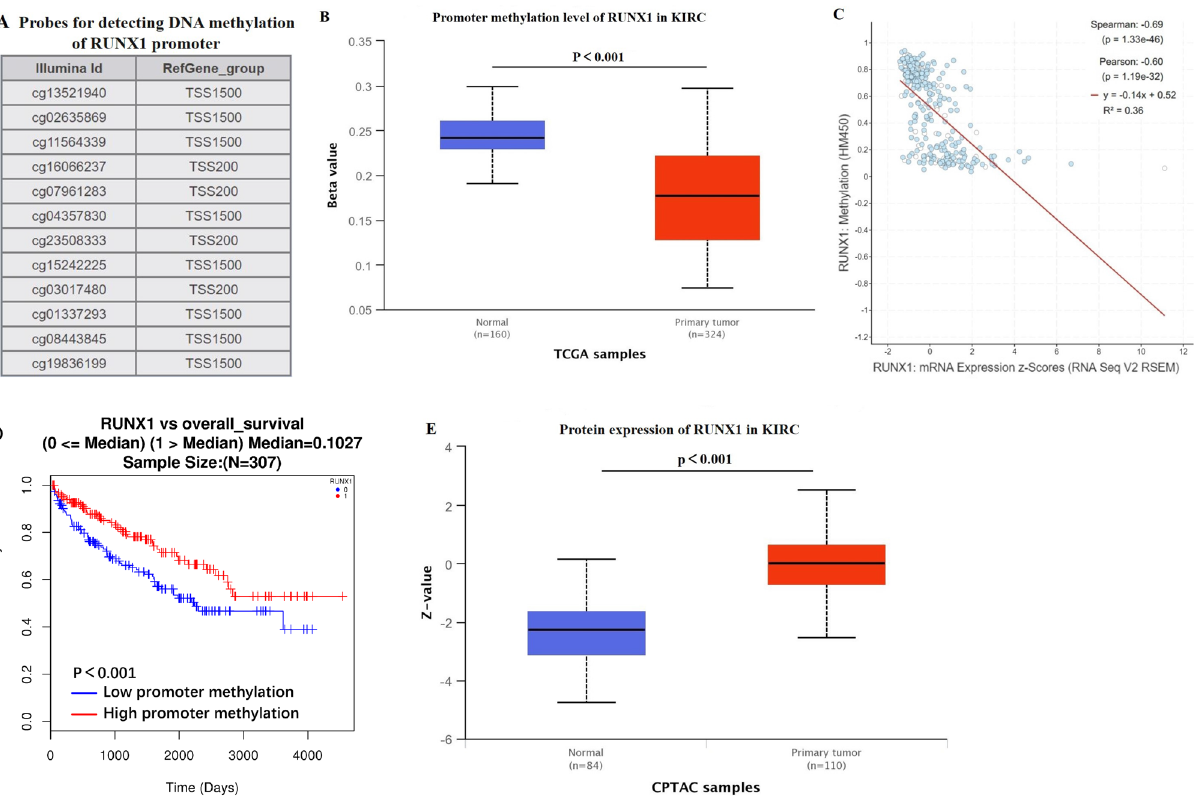
Figure 4. DNA methylation aberration of RUNX1 in KIRC. ( A ) Probes for detecting DNA methylation of RUNX1 promoter. ( B ) UALCAN analysis about the promoter methylation levels of RUNX1 in KIRC and normal samples. ( C ) The correlation analysis between the promoter methylation level of RUNX1 and its expression level based on cBioPortal database. ( D ) Correlation analysis between the promoter methylation level of RUNX1 and overall survival in KIRC patients by LinkedOmics. The blue line indicated low methylation level of RUNX1 , while the red line indicated high level. ( E ) CPTAC analysis about the comparison of RUNX1 protein expression between normal and KIRC tissues. KIRC: kidney renal clear cell carcinoma.